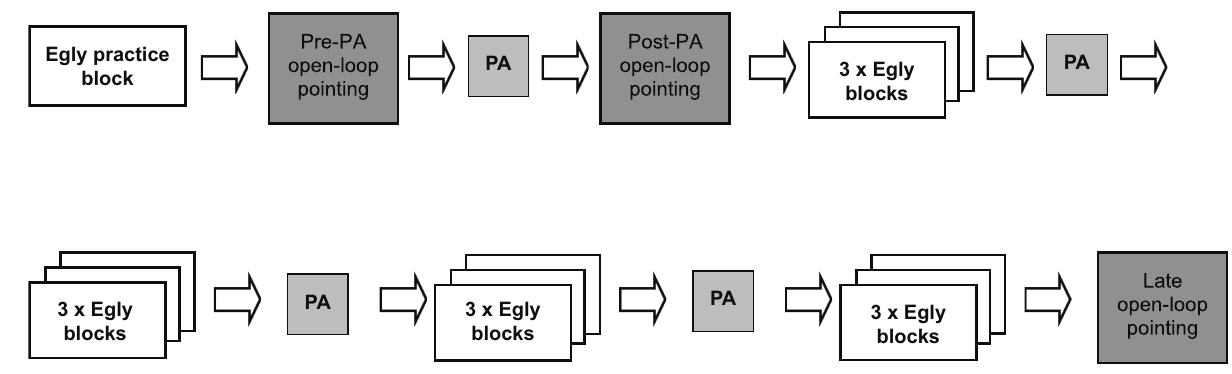
Figure 1. General procedure. PA = prism